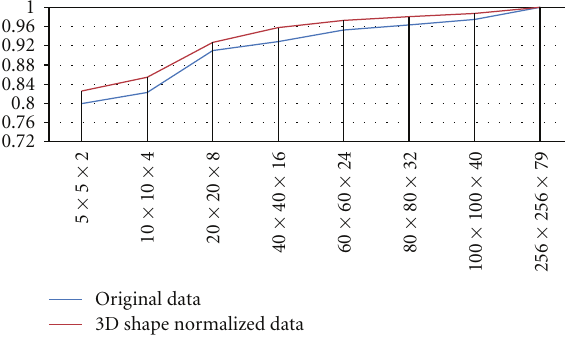
the fixed volume and normalized the other dataset to the same